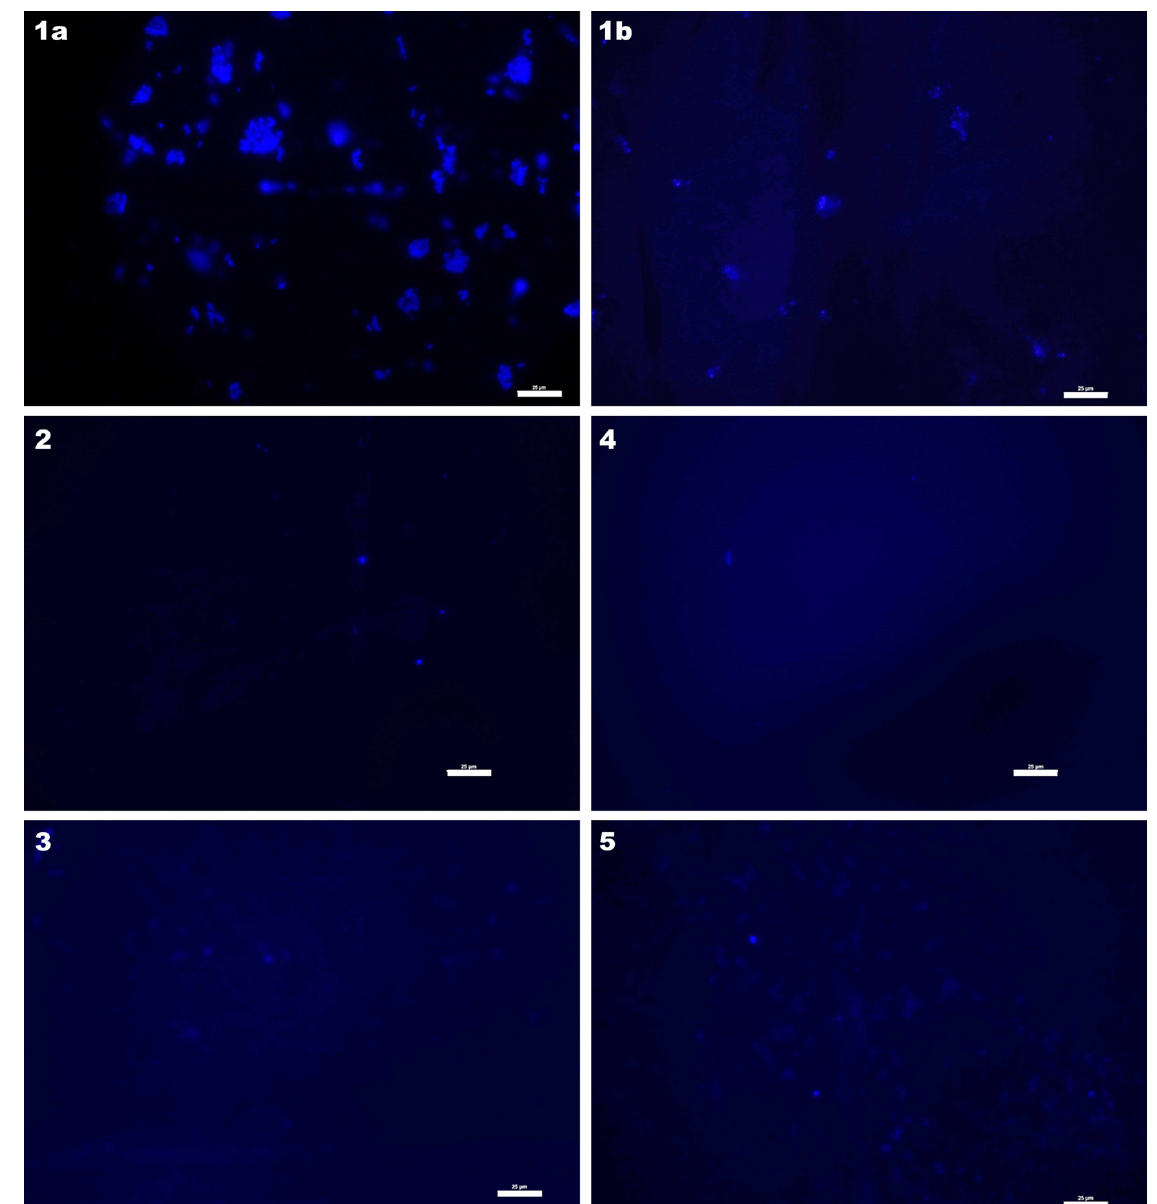
Figure 9. Adhesion of Aeromonas hydrophila to glass (control) and the functionalized silicones. The results were compared to those for the control glass carrier. Values with letters show statistically significant differences: a, p ≥ 0.05; b, 0.005 < p < 0.05; c, p < 0.005.